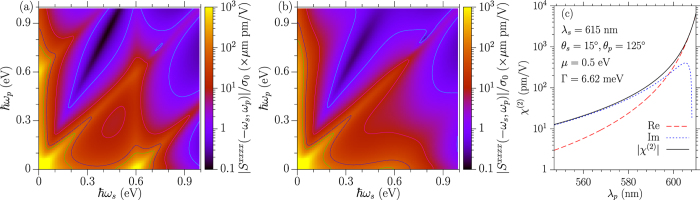
The contour plot of the response coefficients |Sxxxx(−ωs, ωp)| at (a) T = 0 K and (b) T = 300 K for μ = 0.3 eV and Γ = 33 meV. The contour lines correspond to the values 1, 10, 50, and 100 in the units indicated. (c) An effective  with the parameters taken from the experiment25 by Constant et al. Here ωi = 2πc/λi, and qi = ωi/c cos θi with i = s, p. The other parameters are μ = 0.5 eV, Γ = 6.62 meV, and T = 0 K.